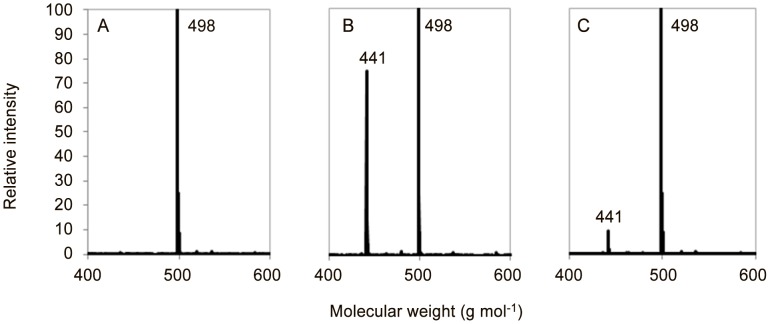
Peptidase activity of PC66–591 and PC66–300.LC-ESI-MS product-ion mass spectra of the reaction mixtures incubated at 37°C for 30 min (A) 1 mM GS-bimane, 10 mM β-Me, 0.1 mM CdCl2, 200 mM Tris-HCl (pH8) (GS-bimane m/z 498) and (B) 1 mM GS-bimane, 10 mM β-Me, 0.1 mM CdCl2, 200 mM Tris-HCl pH8 and 5 µg of recombinant SmPCS66–300 (γ-Glu-Cys-S-bimane m/z 441) and (C) 1 mM GS-bimane, 10 mM β-Me, 0.1 mM CdCl2, 200 mM Tris-HCl pH8 and 5 µg of recombinant SmPCS66–591.